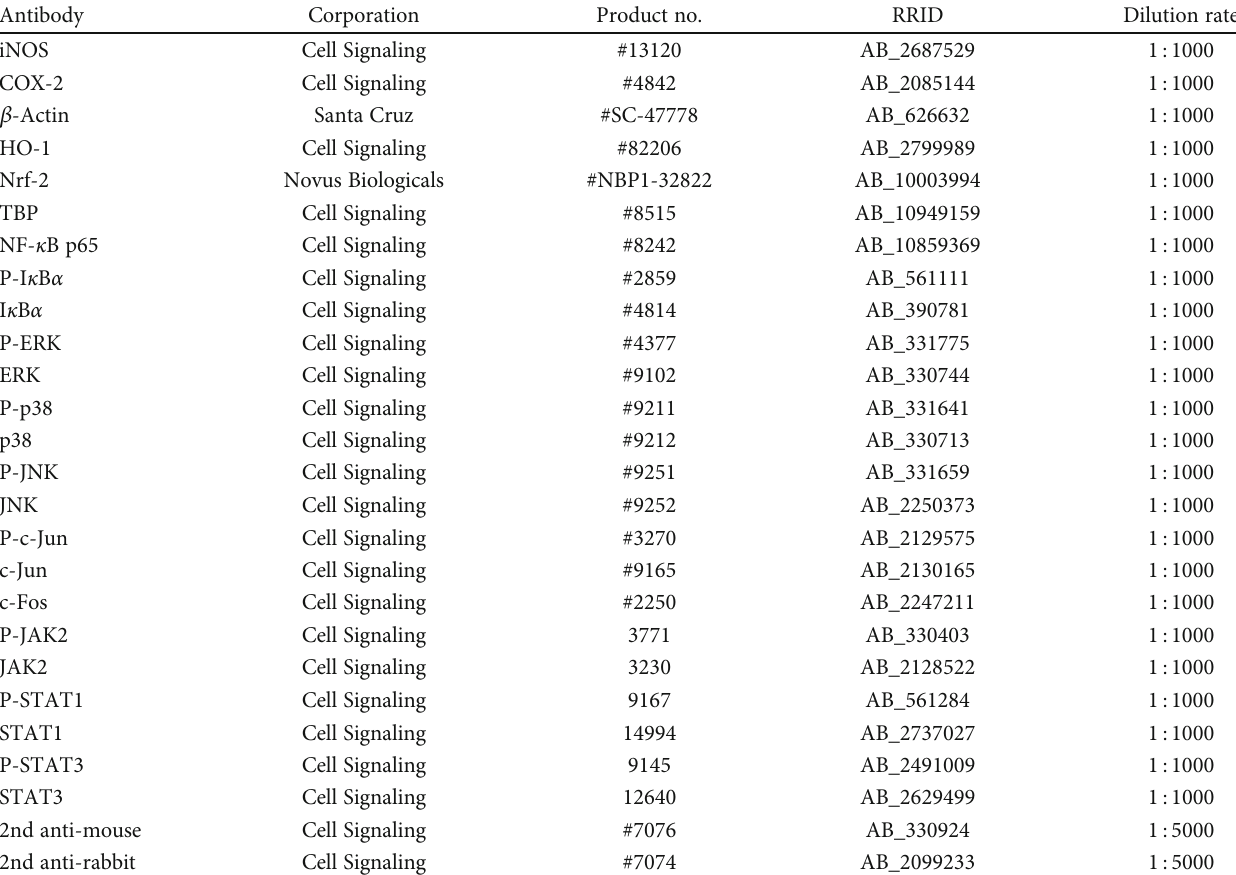
Table 2: Primary and secondary antibodies used for Western blotting